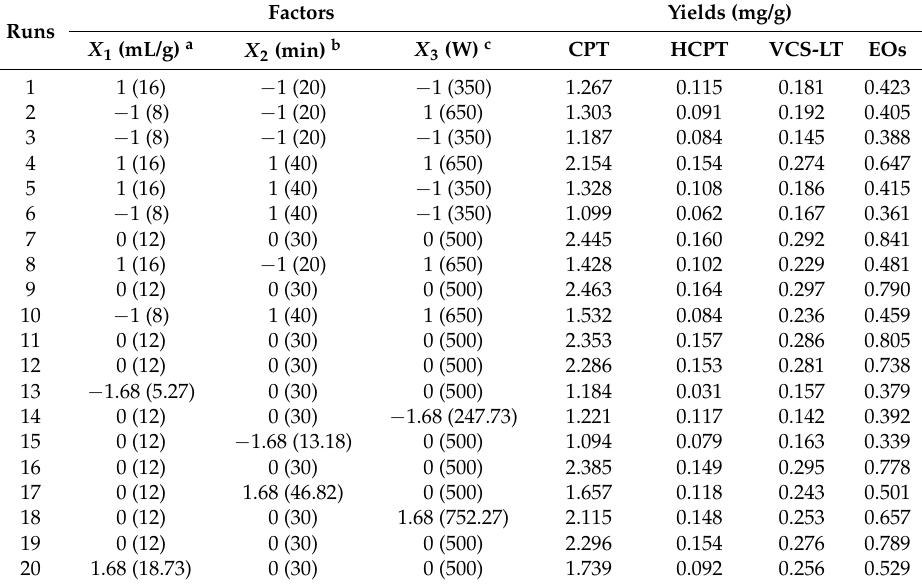
Table 1. Experimental conditions used in the central composite design analysis and the corresponding measured